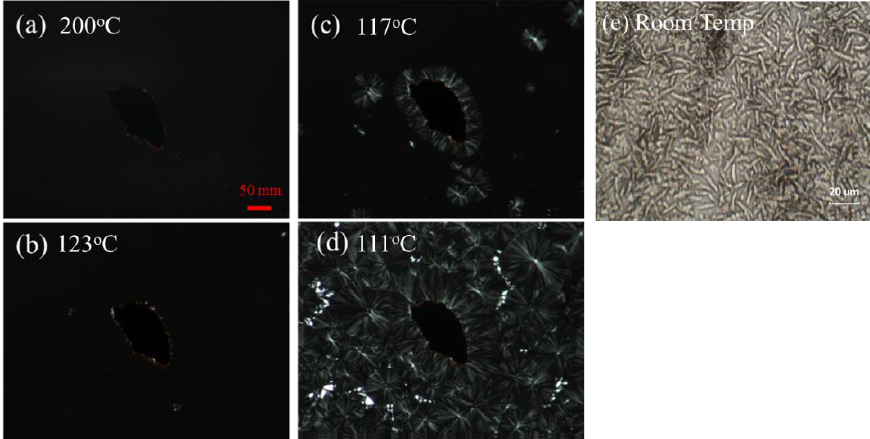
Figure 6. The optical micrographs of transcrystallization in solution-cast i-PP/CuNWs composites during cooling from ( a ) 200 °C to ( b ) 123 °C, ( c ) 117 °C, ( d ) 111 °C, and ( e ) room temperature.